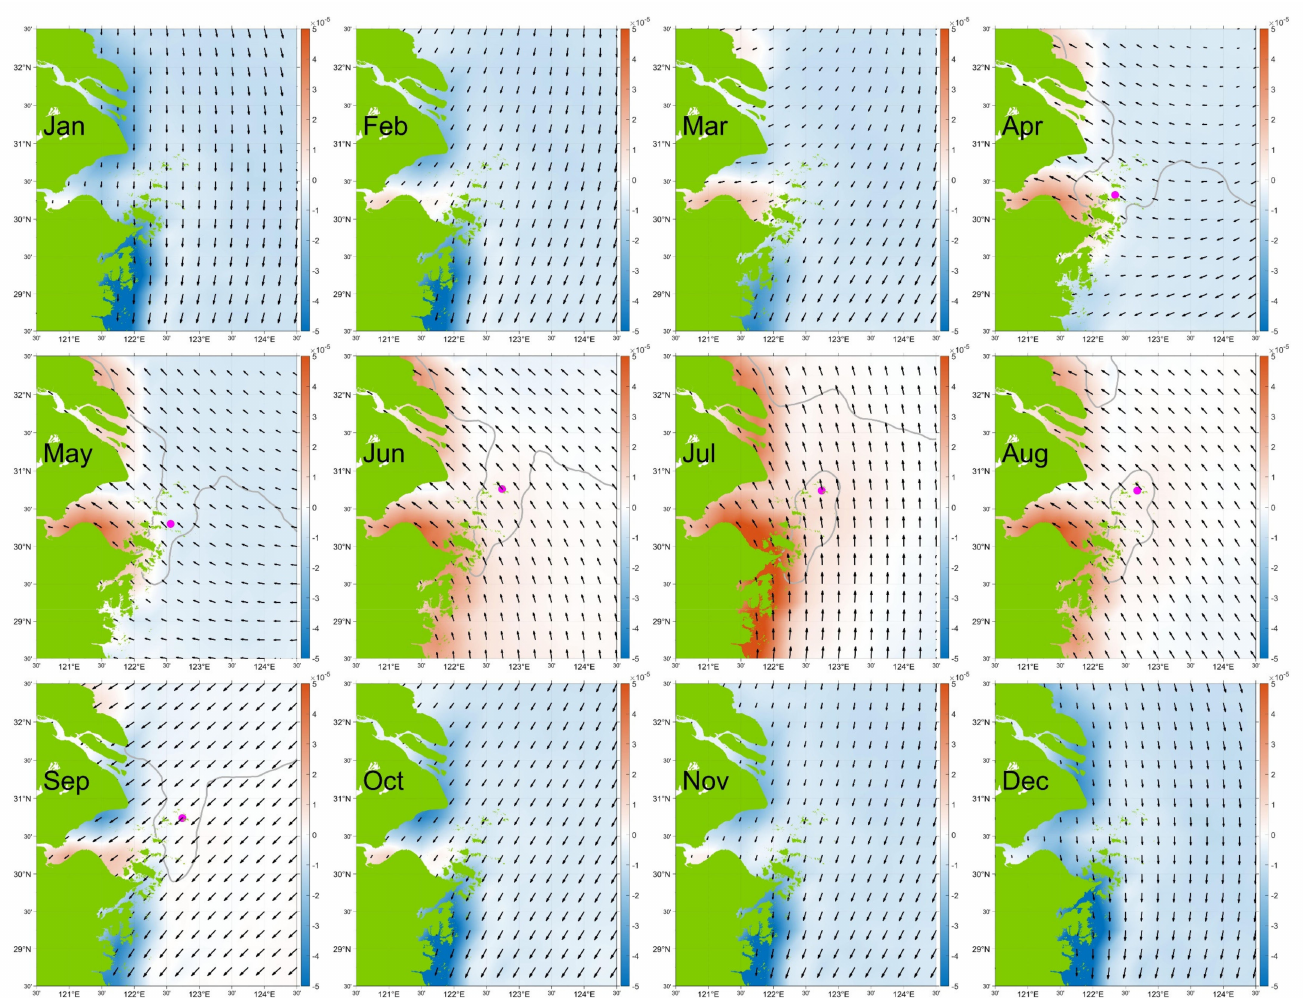
Figure 6. The cross − calibrated multi-platform monthly sea surface wind field (black vector, m/s) and wind curl (shade color, s − 1 ) between 2015 − 2021. The magenta dot shows the location of the upwelling center extracted from the monthly SST. The gray line is the boundary of core